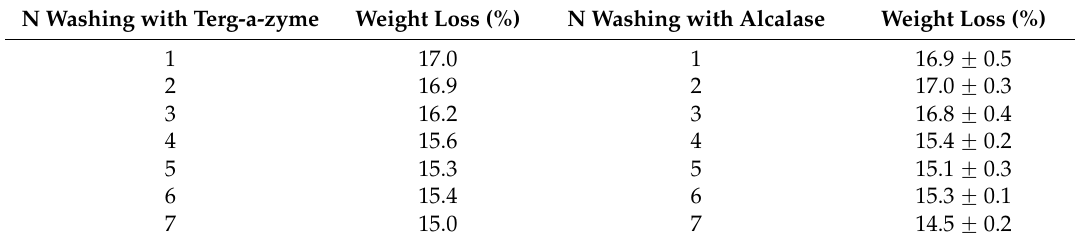
Table 7. Weight loss in in PE/Whey/PET samples treated with 4% Terg-a-zyme or Alcalase at 20 °C for 2 h.